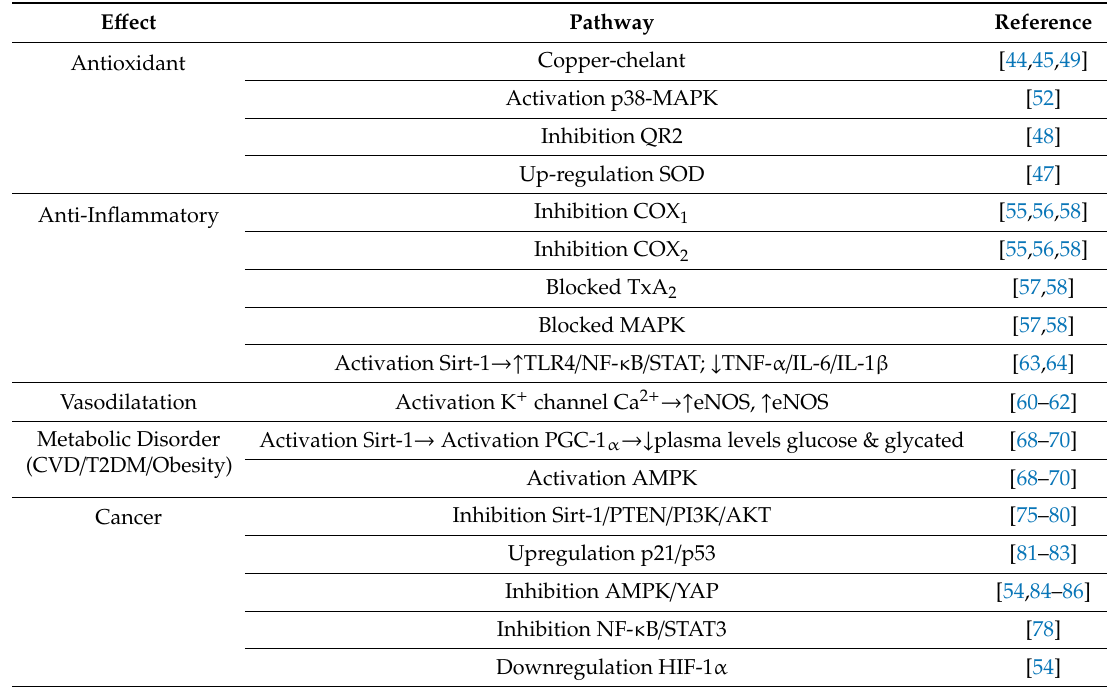
Table 1. Resveratrol main e ff